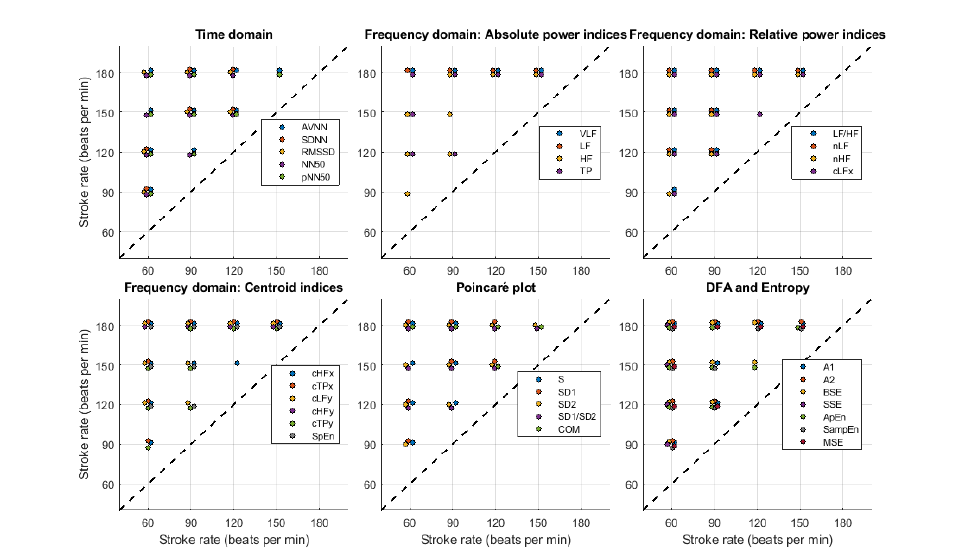
Figure 11. Post-hoc comparisons for stroke rate (SR) levels when pulse rate variability indices are measured from the radial phantom. The appearance of a circle indicates a significant difference between the corresponding levels for each of the indices.